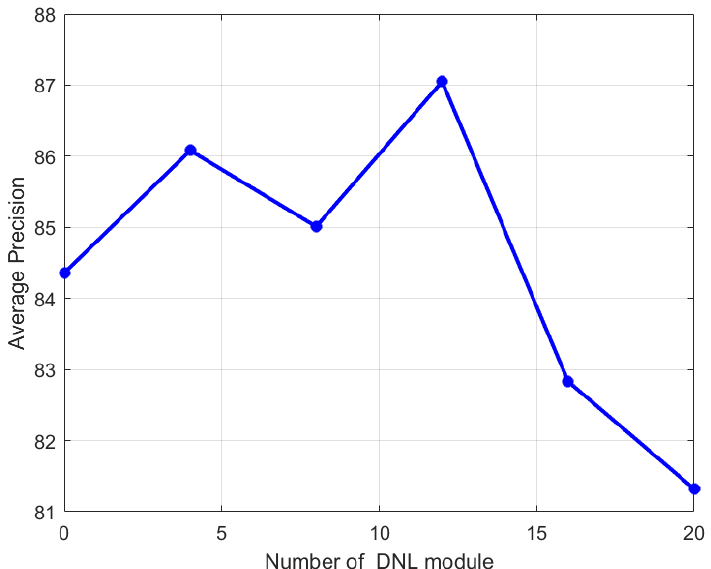
Figure 7. Overall average precision (%) versus different numbers of DNL module in each CSPX structure based on the Nan-Hai